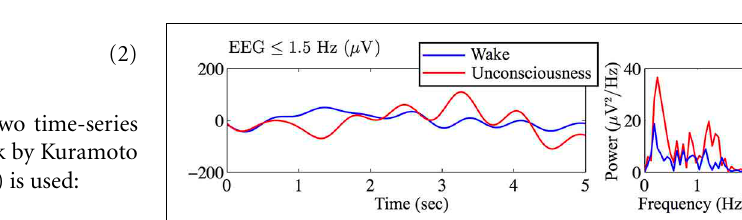
FIGURE 2 | Filtered Figure 1 EEG in sub-delta band ( ≤ 1.5Hz) and corresponding power spectra (computed by M ATLAB fft ) revealing a strong slow-wave ( ∼ 0.3Hz) in the sedated unconsciousness